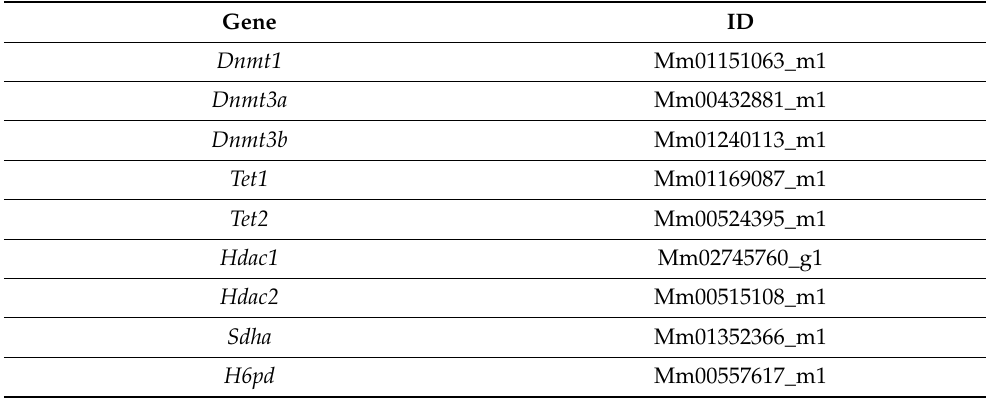
Table 2. References of the probes used for the RT-qPCR TaqMan amplification assay in Tg338 mice. ID = identification of the commercial company (Thermo Fisher Scientific, Waltham, MA,